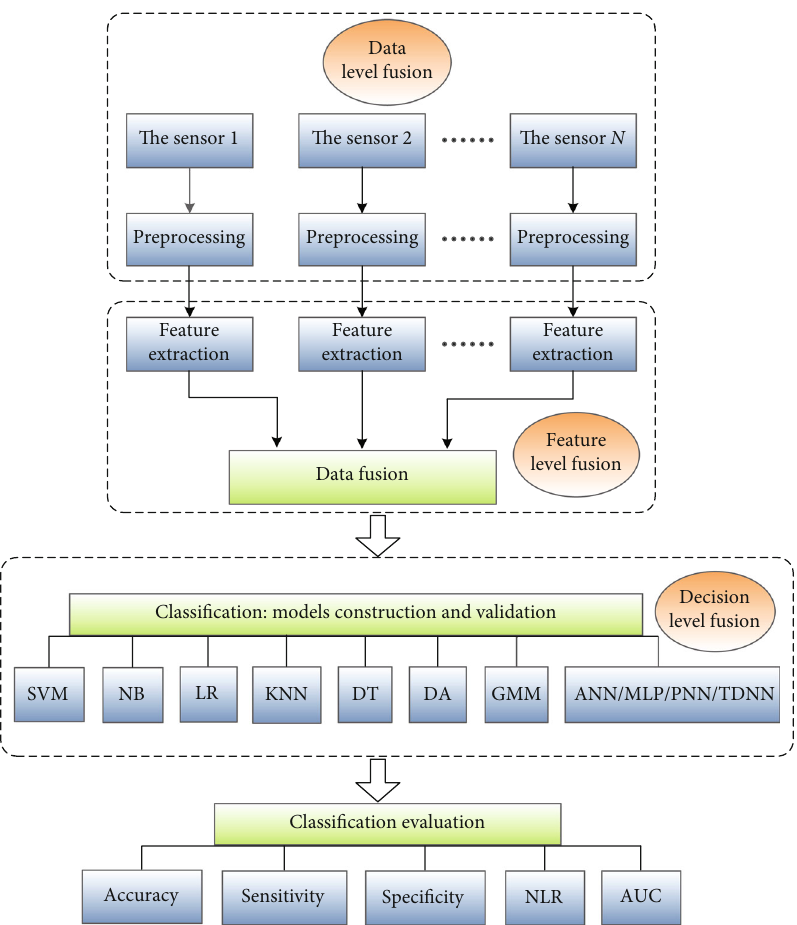
Figure 2: Schematic diagram of a standard procedure implemented for gait recognition using data fusion. The acronyms used in this diagram correspond to the following: SVM: support vector machine; NB: Naive Bayes; LR: logistic regression; KNN: K-nearest neighbors; DT: decision tree; DA: discriminant analysis; GMM: Gaussian mixture model; ANN: arti fi cial neural network; MLP: multilayer perceptron; PNN: probabilistic neural network; TDNN: time delay neural network; NLR: negative likelihood ratio; AUC: area under the